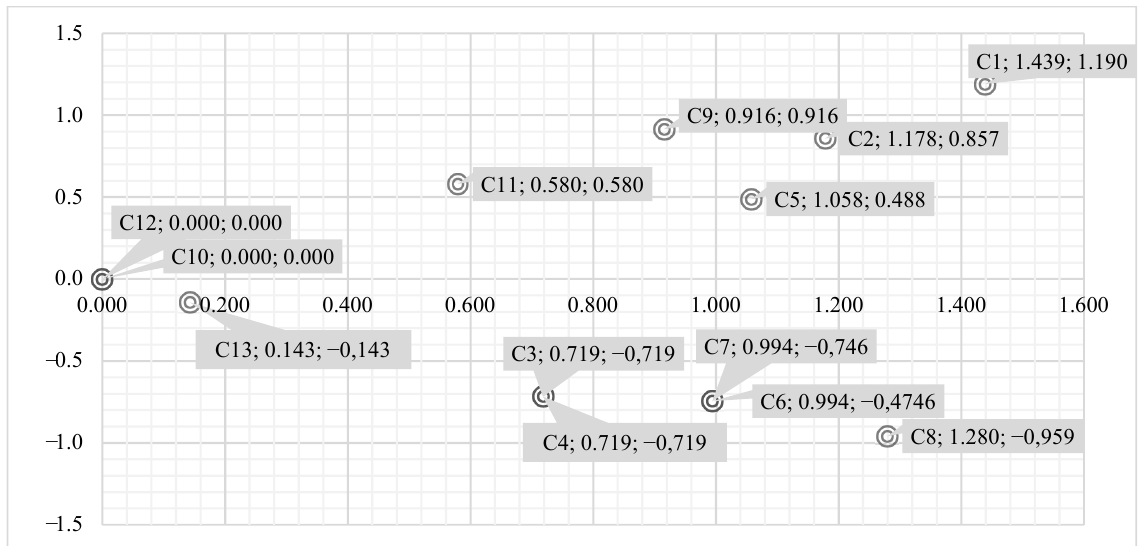
Figure 4. Cause-and-effect diagram. Source: author’s work.